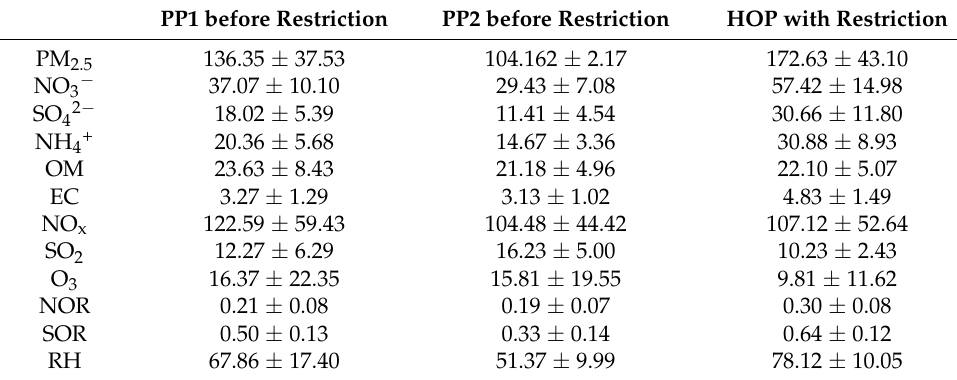
Table 2. Average concentration and deviation (in µ g m –3 ) of PM 2.5 , PM 2.5 contents of ions, OM, EC, and precursor gases of SO 2 and NO x ; average rates of gas-to-particle conversion (NOR, SOR); and RH (in %) in the three periods of PP1, PP2, and